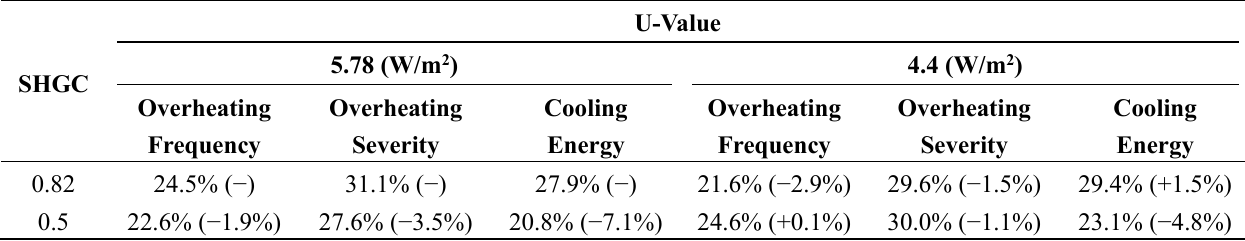
Table 4. The effectiveness matrix of the blind with various combination of SHGCs and U-values of the